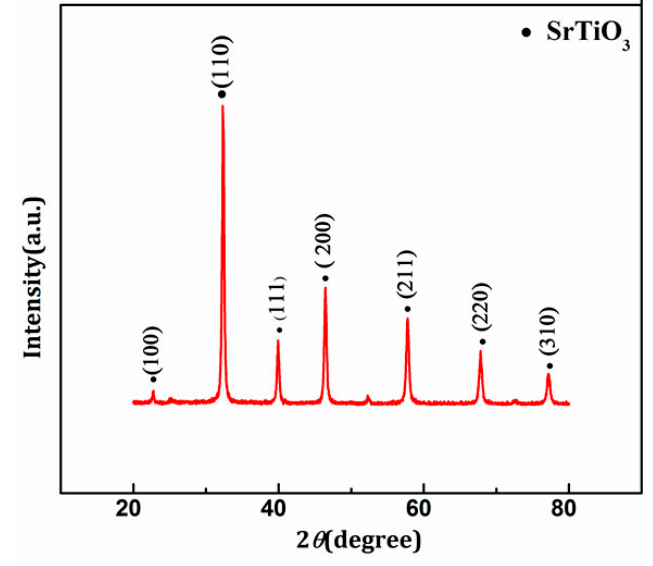
Figure 3. XRD pattern of pure SrTiO 3.